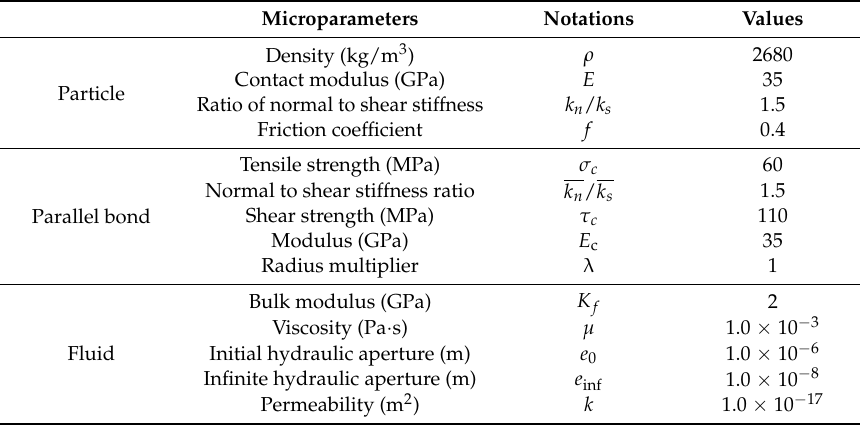
Table 1. Micro physico-mechanical parameters of hydraulic fracturing